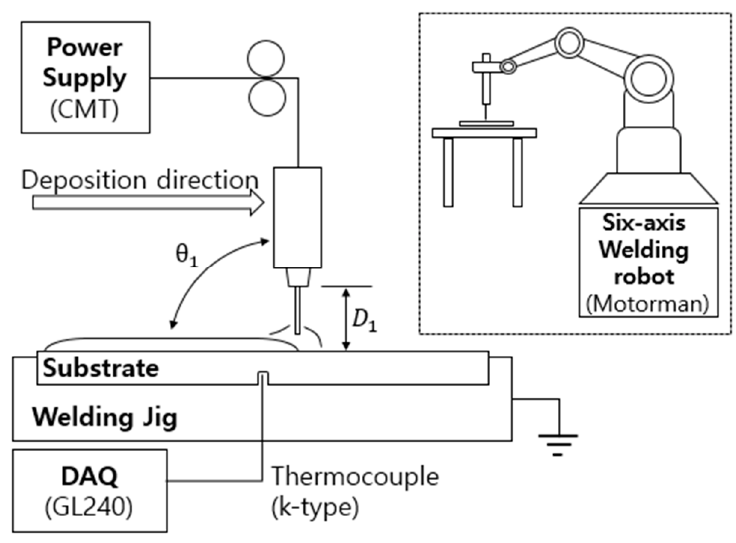
Figure 1. Schematic diagram of MIG based additive manufacturing (AM) systems for Al alloy. CMT: cold metal transfer; DAQ: